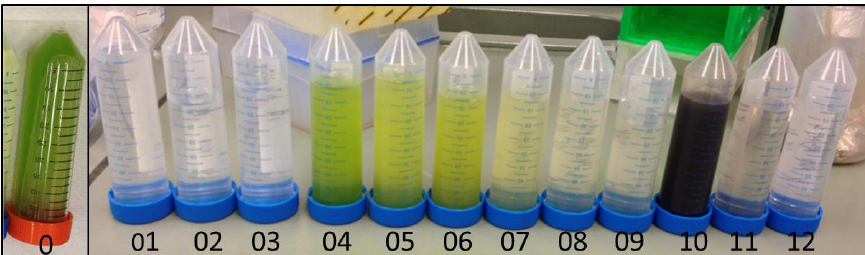
Figure 7. Fractions of the HGMS process with 5 L microalgae suspension, 0.5 g BION /g microalgae , pH 6.75. Fraction 0 shows the native algae suspension (initial situation); fraction 01 corresponds to the separation step and includes the BG-11 medium; fraction 02 and 03 were collected after washing and are mainly residual salts in water; fractions 04 to 09 were collected during the microalgae recovery steps and contain only microalgae and water; fractions 10 to 12 were collected during the BIONs resuspension step and correspond to the recovery of the